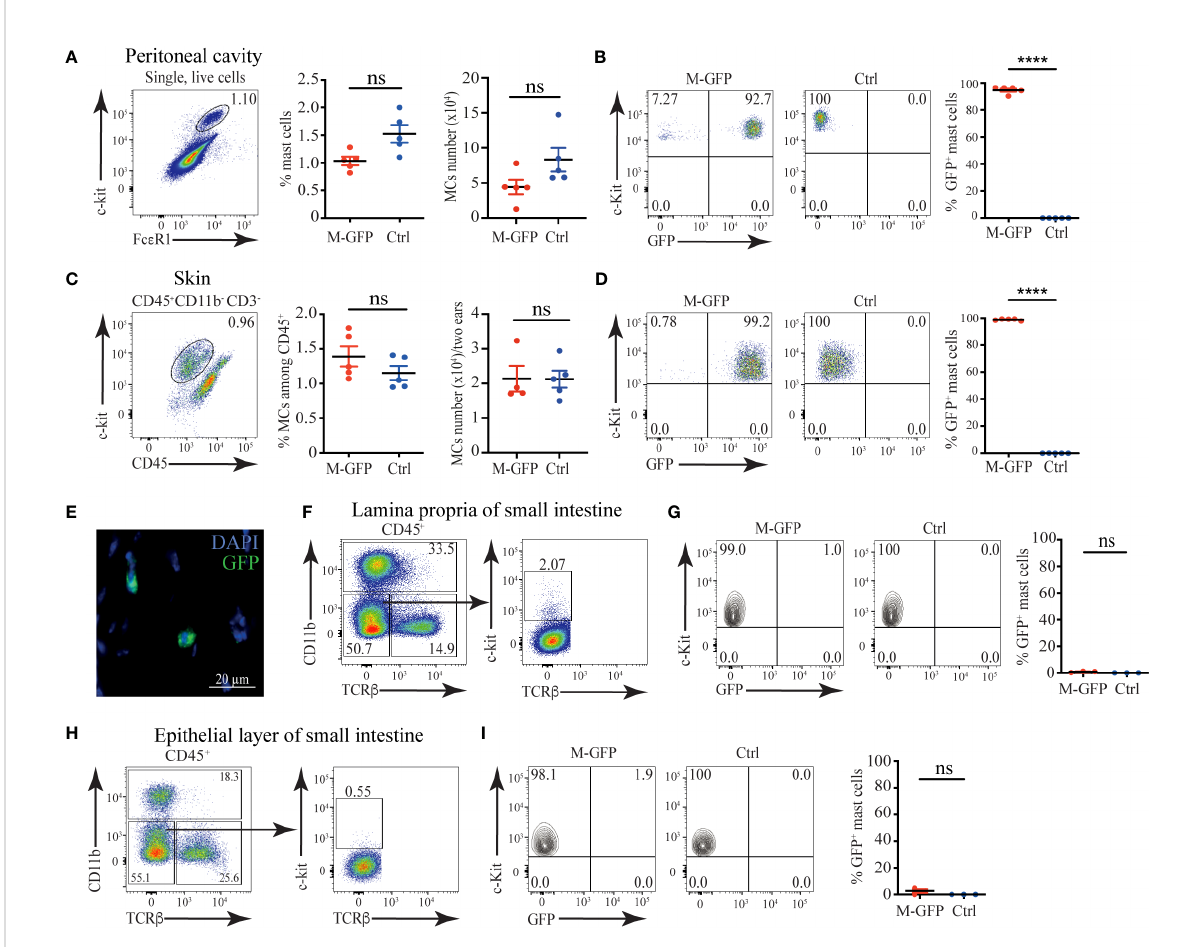
FIGURE 1 Connective tissue MCs are ef fi ciently labeled in Mcpt5 Cre X ROSA26 LSL-GFP (M-GFP) mice. (A) Representative gating strategy, percentages, and numbers of c-kit + Fc e R1 + MCs among peritoneal exudate cells in M-GFP and control mice determined by fl ow cytometry. (B) Representative fl ow cytometry plots and percentages of GFP + peritoneal MCs in M-GFP and control mice. (C) Representative gating strategy, percentages, and numbers of skin MCs in M-GFP and control mice determined by fl ow cytometry. (D) Representative fl ow cytometry plots and percentages of GFP + skin MCs in M-GFP and control mice. (E) Representative immuno fl uorescent microscopy image of skin MCs in M-GFP mice. (F) Representative gating strategy and percentages of MCs among CD45 + cells in lamina propria of the small intestine of M-GFP and control mice. (G) Representative fl ow cytometry plots and percentages of GFP + MCs in lamina propria of the small intestine of M-GFP and control mice. (H) Representative gating strategy and percentages of MCs among CD45 + cells in the epithelial layer of the small intestine of M-GFP and control mice. (I) Representative fl ow cytometry plots and percentages of GFP + MCs in the epithelial layer of the small intestine of M-GFP and control mice. Results are represented as mean ± SEM. Each symbol in the graph represents an individual mouse. Flow cytometry plots in (A – D) are representative of 5 individual experiments, while the plots in (F – H) , and (I) are representative of 3 individual experiments. The image in (E) is representative of 3 different mice. Statistical signi fi cance was determined by unpaired Student ’ s t-test. Values of p < 0.05 were considered statistically signi fi cant, ****p < 0.0001, ns, not signi fi